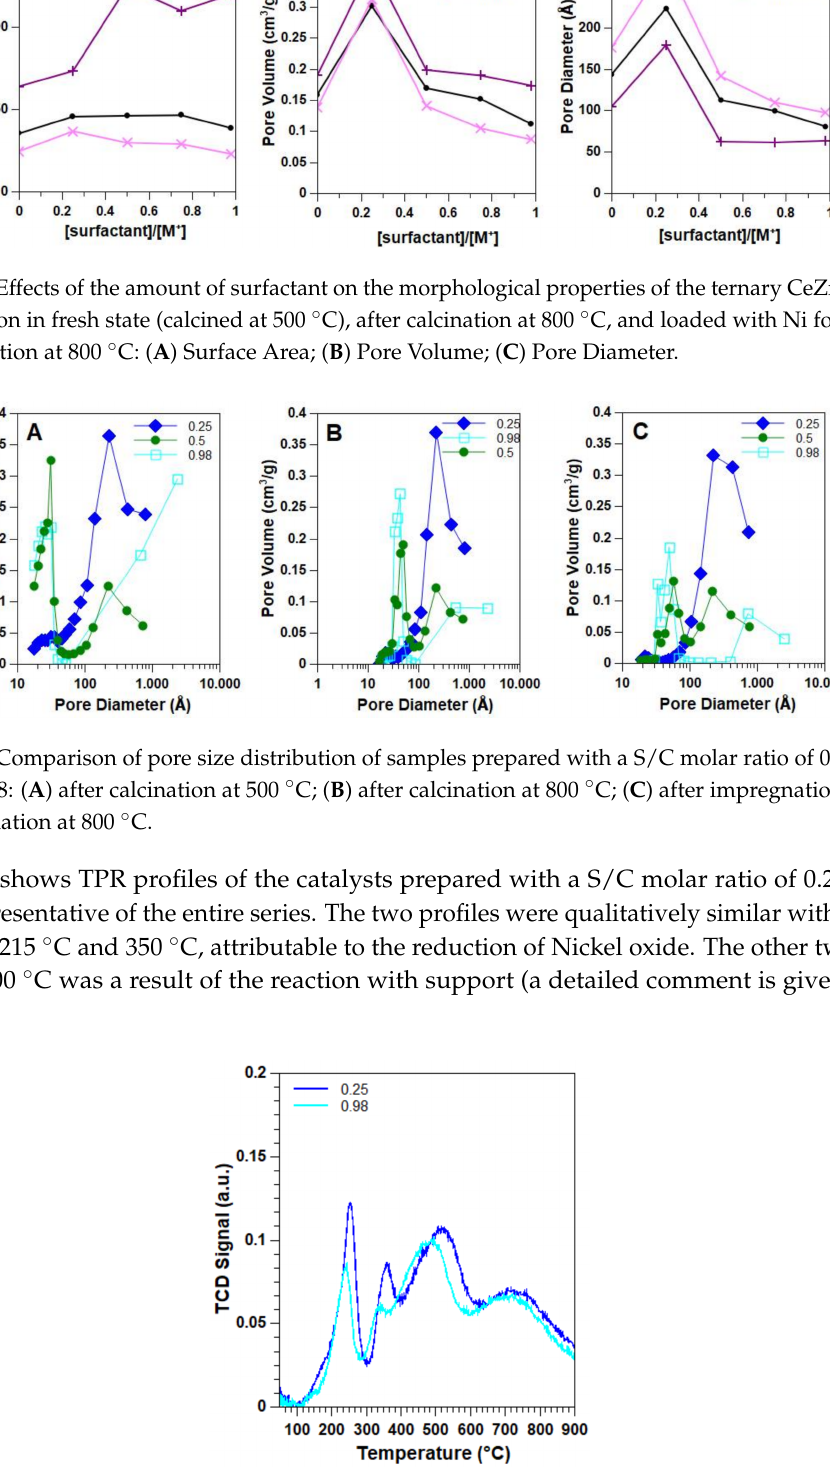
Figure 4. TPR of Ni/CeZrNd 0.07 catalyst prepared with two different surfactant/cations molar